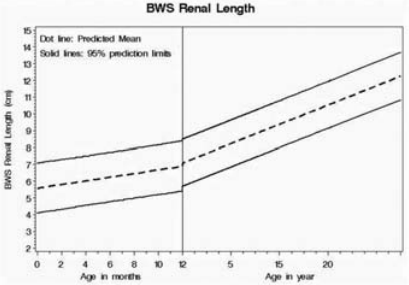
Figure 2 - Renal length and growth of the right kidney of patients with Beckwith-Wiedemann syndrome (BWS)